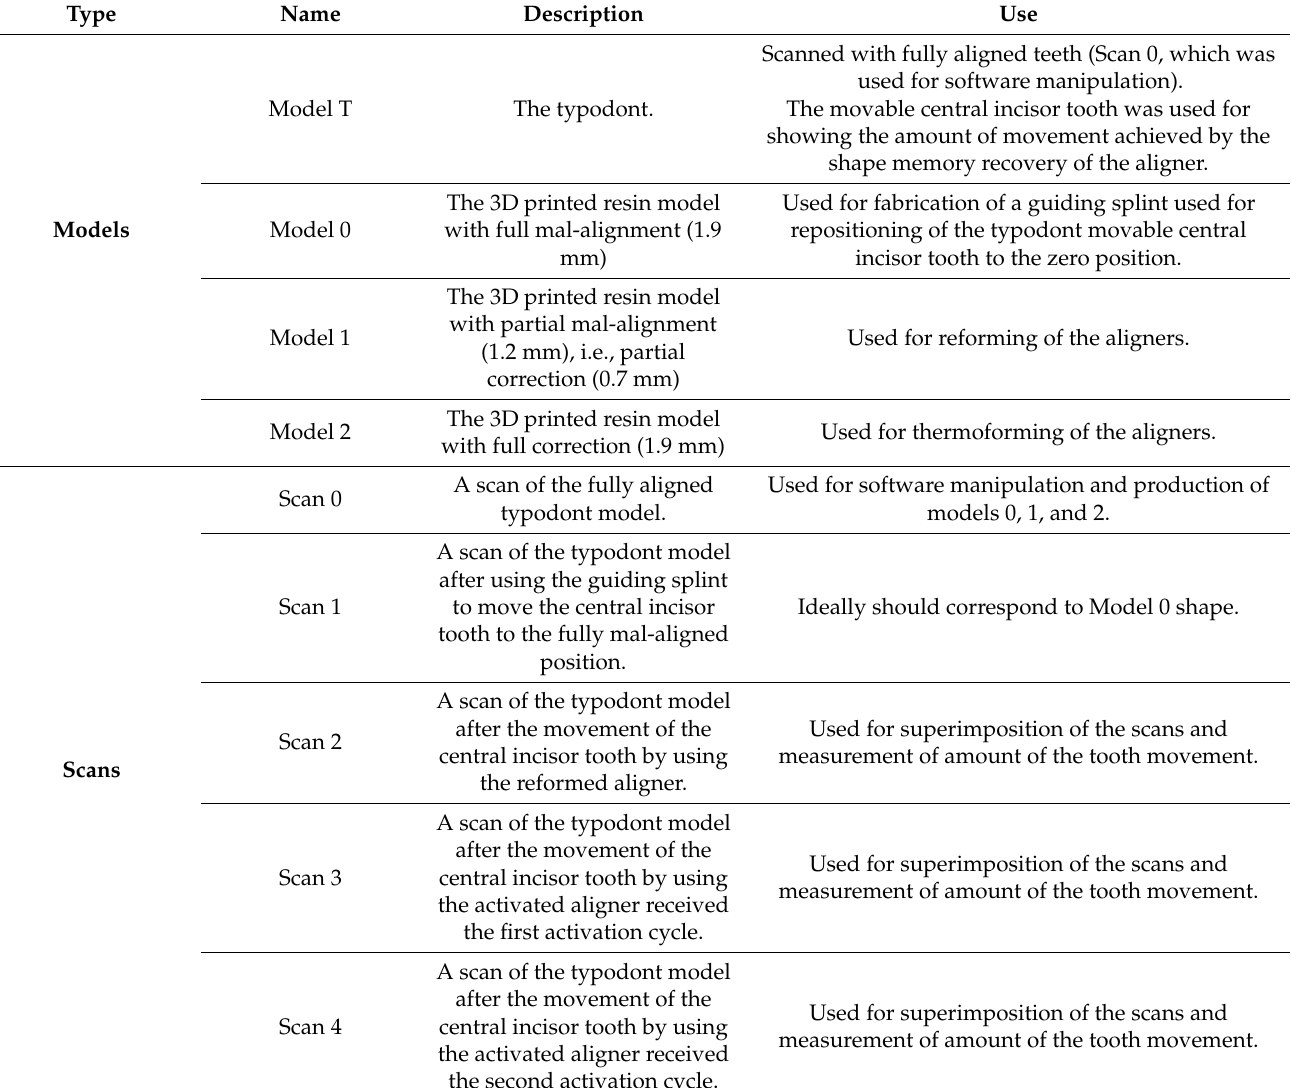
Table 1. A list of models and scans used in the